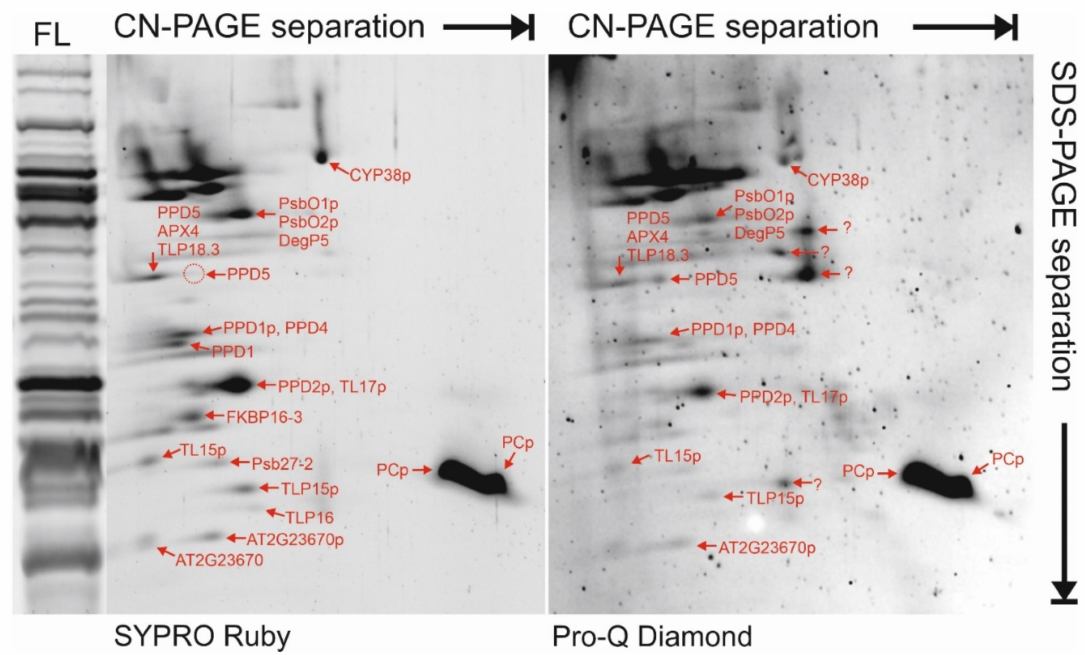
Figure 5. Detection of potential protein complexes and phosphorylation in the thylakoid lumen proteome. The free lumen proteome was separated in two dimensions, first by clear native (CN)-PAGE followed denaturing SDS-PAGE containing 15% acrylamide. The same gel was treated with Pro-Q Diamond phosphoprotein stain, and then with SYPRO Ruby total protein stain. Mono-dimensional separation of the same free lumen (FL) fraction on SDS-PAGE containing 15% acrylamide (stained with SYPRO Ruby) is included as a reference on the left-hand side. Protein spots of interest were excised from the 2D gel, digested with trypsin and identified using mass spectrometry. Proteins identified are indicated on the SYPRO Ruby-stained gel (left), and in some cases also on the Pro-Q Diamond-stained gel (right). The letter ‘p’ indicates that a peptide of the protein was found by MS to be phosphorylated in that spot. Note, some proteins were identified in >1 spot. See Table 2 for more details about phosphorylation. See Supplementary Figure S2 and Supplementary Table S3 for data describing all proteins detected in each